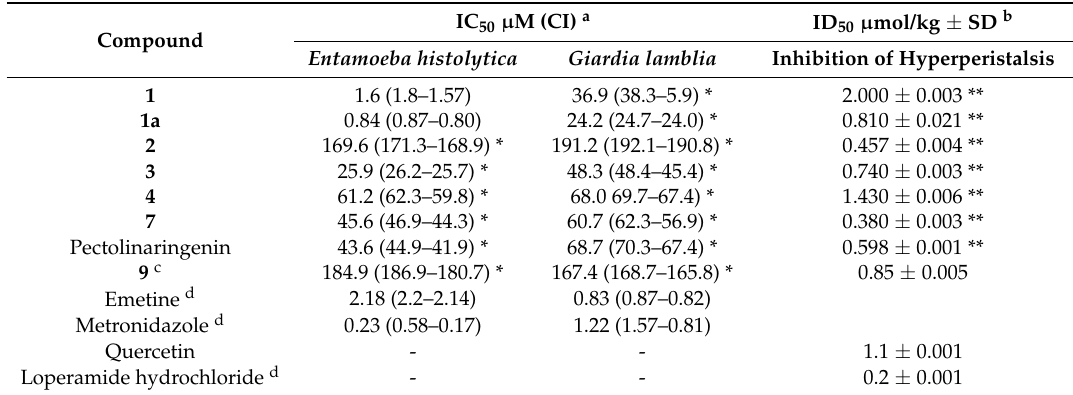
Table 5. In vitro antiprotozoal activity and inhibition of hyperperistalsis of thymol derivatives. Compound